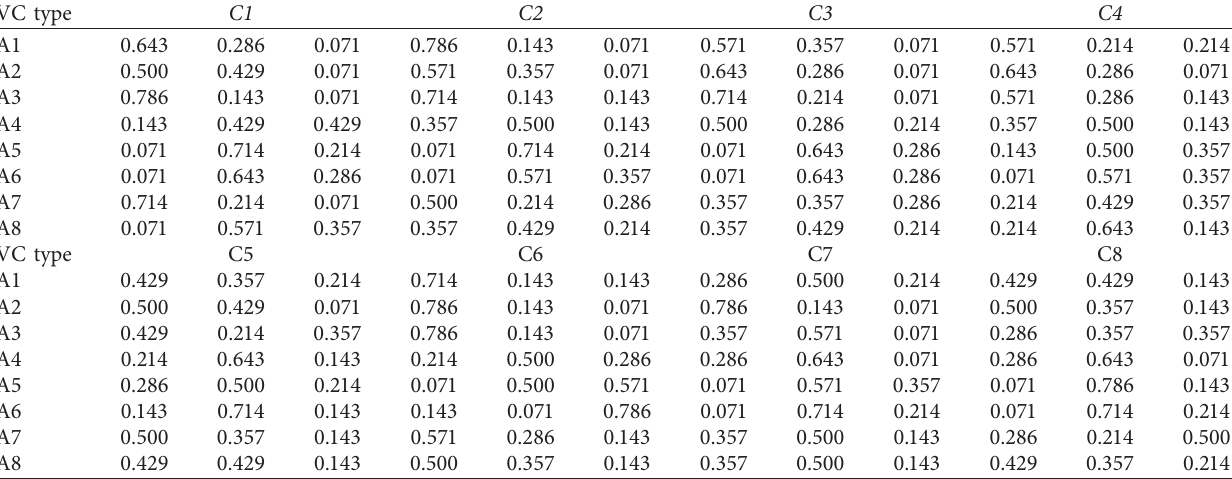
Table 10: Decision matrix expressed in the PF domain.